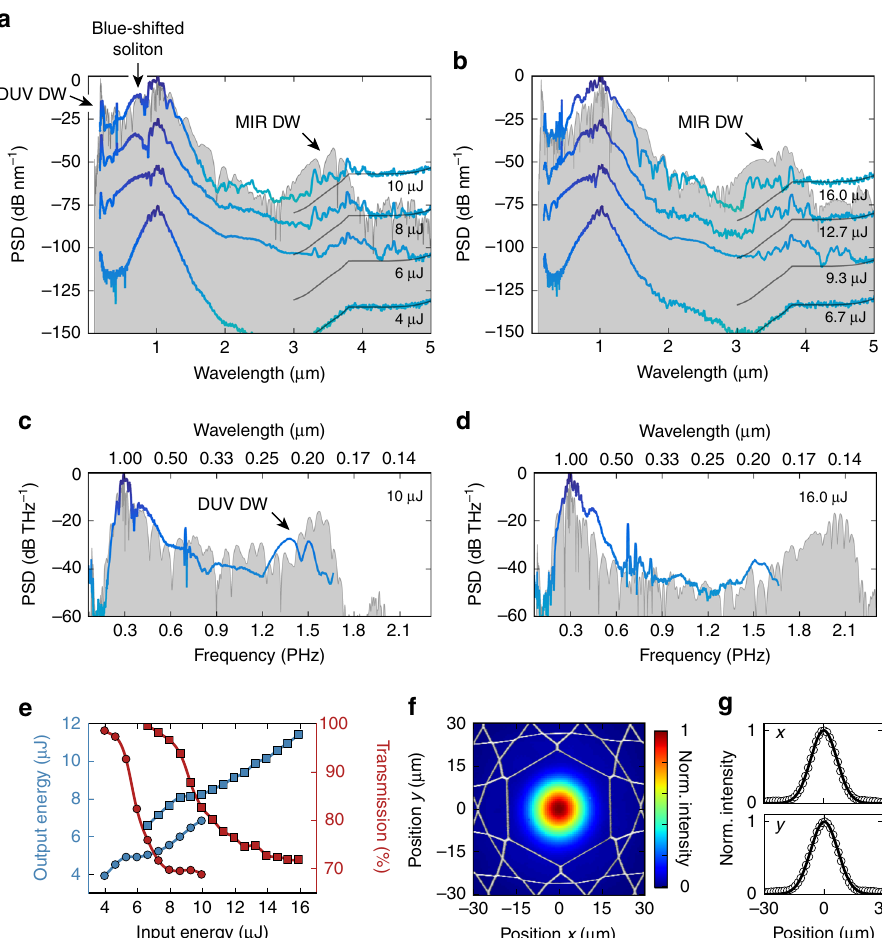
Fig. 1 Experimental results. a Generated output spectra for wavelengths from 180 nm to 5 μ m, when 7 cm of fi bre was fi lled with 4 bar of argon and pumped with pulses of 4, 6, 8 and 10 μ J (the spectra are offset by 25 dB each for clarity). The power spectral density (PSD) is normalized to the peak of the spectra. The PSD from − 100 dB to 0 is mapped to a colour gradient from green to blue. At wavelengths longer than 900 nm, the spectra are corrected for the theoretical relative responsivity of the detectors ( “ Methods ” section), but are otherwise intensity-uncalibrated. This leads to a wavelength-dependent noise level (indicated with black lines between 3 and 5 μ m) that follows the correction curve for the detector response. Below 200 nm, the spectrum is intensity- uncalibrated. In the vicinity of 4.25 μ m, absorption by carbon dioxide in the 2-m-long detection path in air reduces the signal. The relative humidity was ~30%, so that water absorption was negligible in the spectral region of interest. The numerically simulated spectrum ( “ Methods ” section) at 9.7 µ J is shown by the curve under-shaded in grey. Dispersive waves (DWs) are emitted in the deep ultraviolet (DUV) and mid-infrared (MIR). b Same as in a , but for 30 bar of neon and 15.7 μ J for the simulation. c , d Spectra versus frequency corresponding to a , b , scaled by λ 2 / c ( λ is wavelength and c the speed of light in vacuum) to represent the correct frequency-scaled PSD. e Output energy (blue) and overall transmission (red) of the fi bre (including coupling ef fi ciency into the fi bre) for the two cases in a (circles) and b (squares). f Near- fi eld optical micrograph of the output mode for wavelengths longer than 3.1 μ m, when the fi bre was fi lled with 4 bar of argon and pumped with 6.6 μ J pulses, with the microstructure of the kagomé-photonic crystal fi bre superimposed. The intensity is normalized to the maximum value. g Normalized intensity pro fi les in orthogonal directions through the centre of the mode in f . The dots are measured points and the lines Gaussian fi